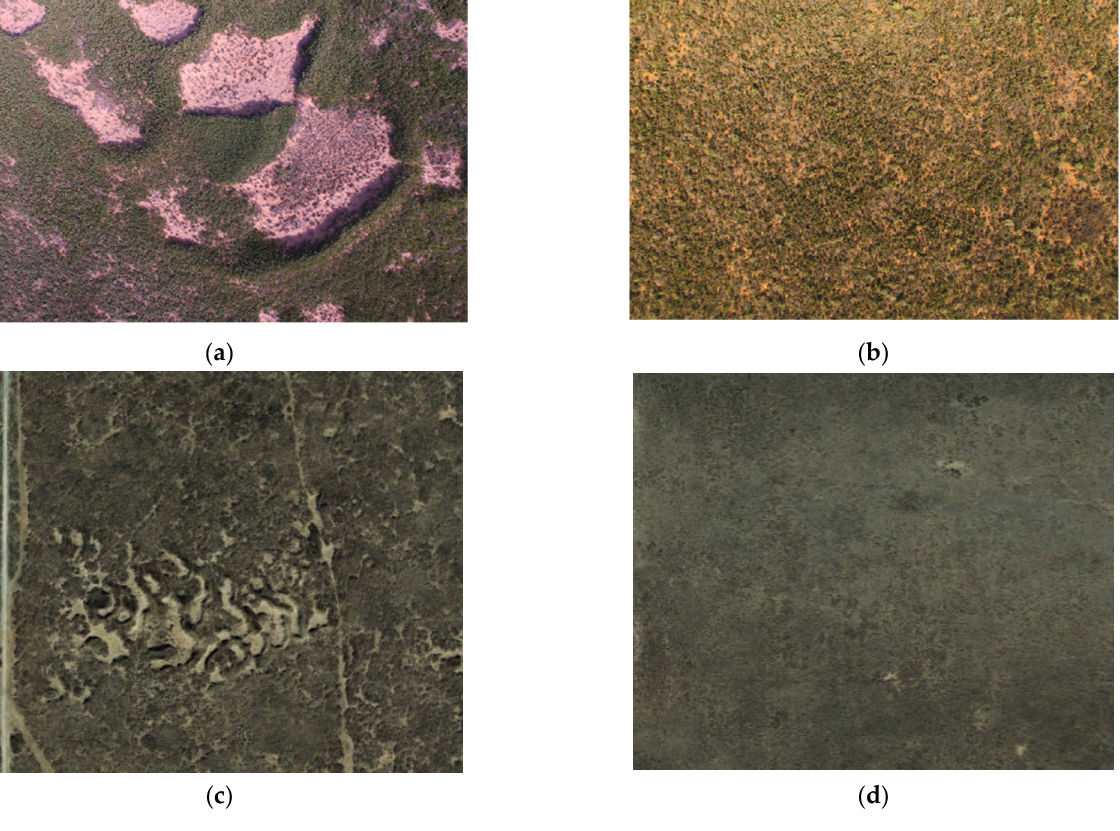
Figure 2. Landscape-scale view of sand shinnery oak-dominated grasslands and mixed grasslands from an UAV platform and high-resolution spaceborne imagery (0.5 m pixel resolution): ( a ) sand shinnery oak-dominated grassland from UAV (Weaver Ranch, NM, USA); ( b ) mixed grassland from UAV (Weaver Ranch, NM, USA); ( c ) sand shinnery oak-dominated grassland from high-resolution imagery in Google Earth Pro (Yoakum, TX, USA); and ( d ) mixed grassland from high-resolution imagery in Google Earth Pro (Yoakum, TX, USA).